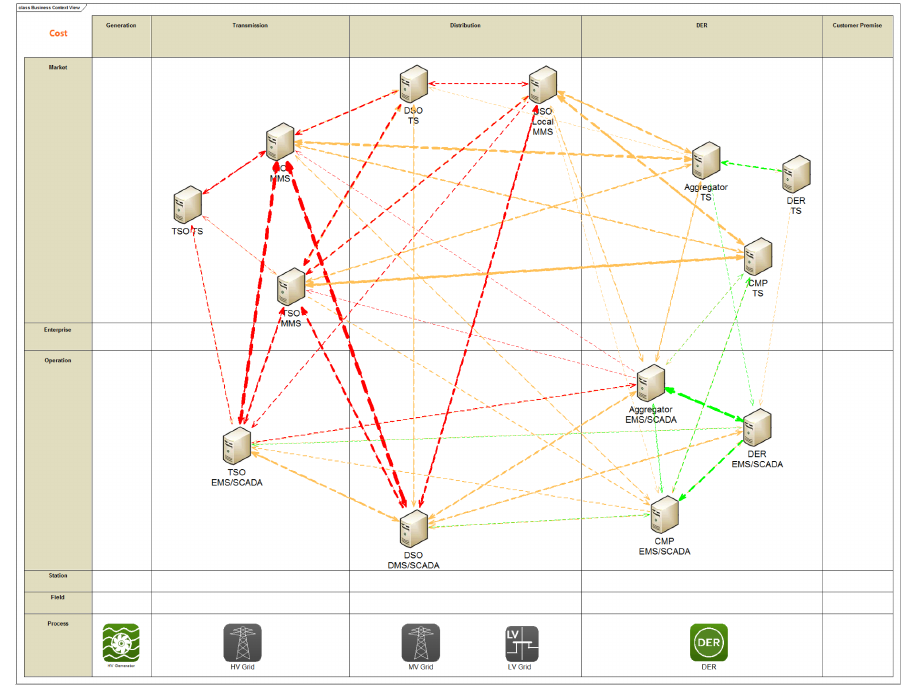
Figure 10. Communication links with different costs: high cost (red), medium cost (orange), and low cost